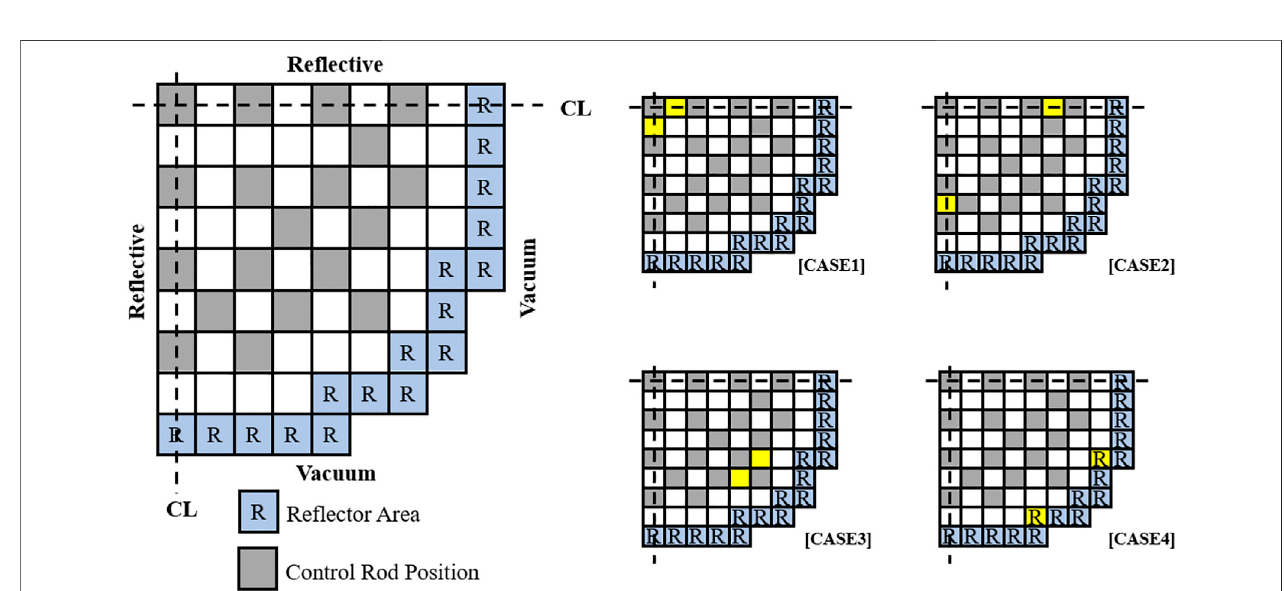
FIGURE 8 | KWU 2D core con fi guration.